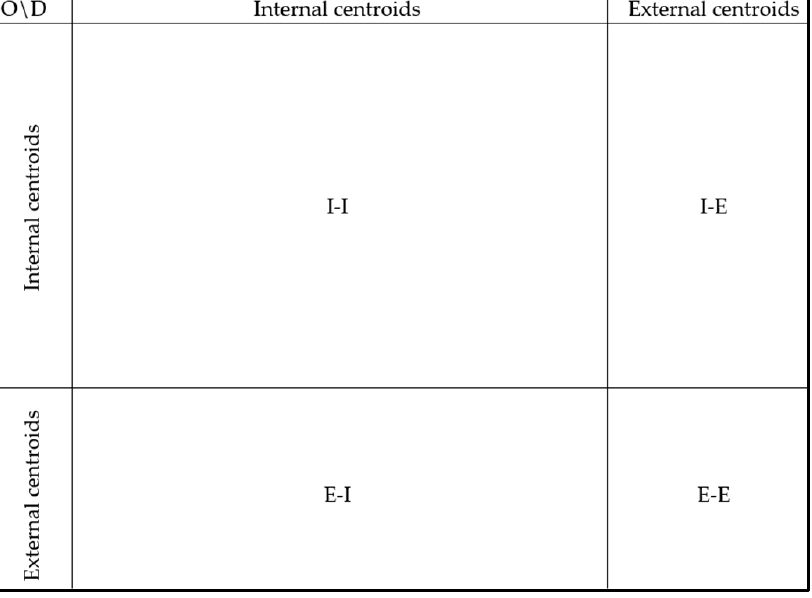
Figure 11. Road network (regional model). Once the regional OD matrix was estimated, in terms of freight vehicles/year, with the transport supply model, we estimated the traffic flows on the network through a de- terministic assignment procedure, such as the one already used for the national-scale model. The results of the assignment are shown in Figure 12. The high values, compared to the others, were expected in the exchange and crossing flows. The results in terms of vehicle-km/year are summarised in Table 5.